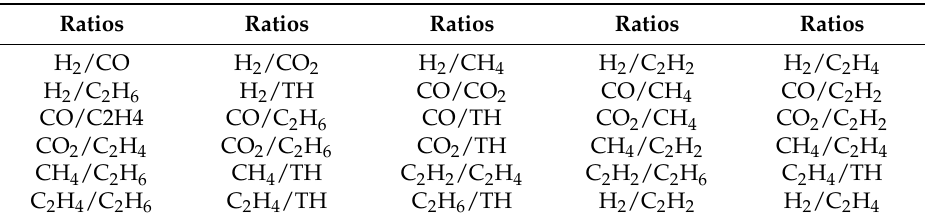
Table 1. Dissolved gas analysis (DGA)